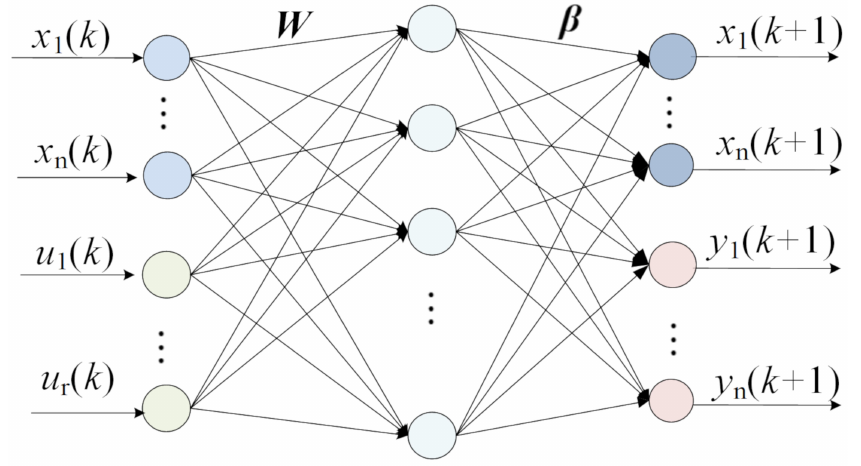
Figure 1. AFOS-ELM neural network